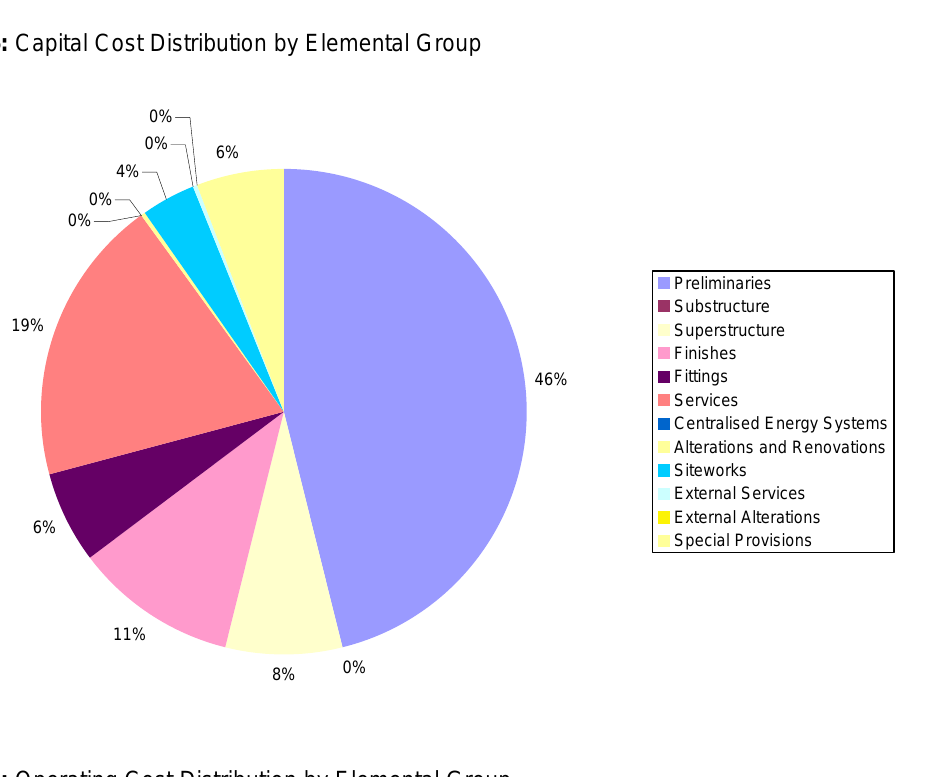
Figure 7: Operating Cost Distribution by Elemental